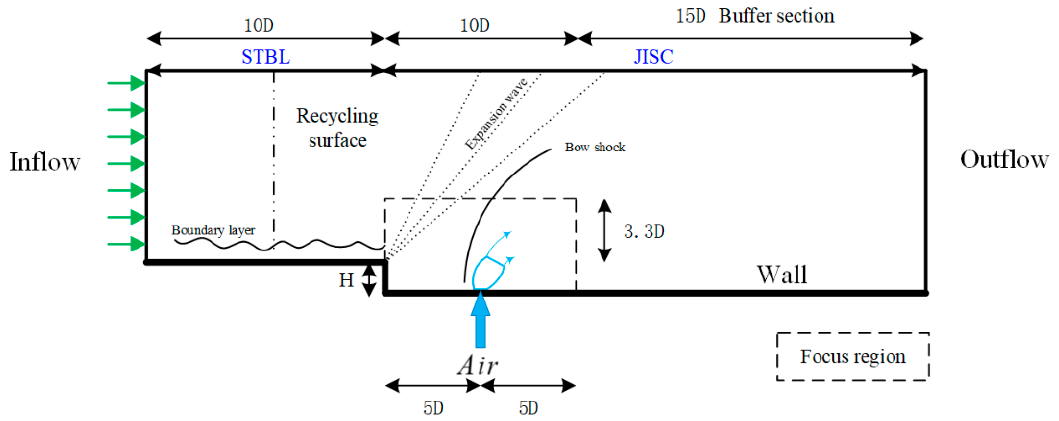
Table 1. Conditions of crossflow and jet in the experiment [24].